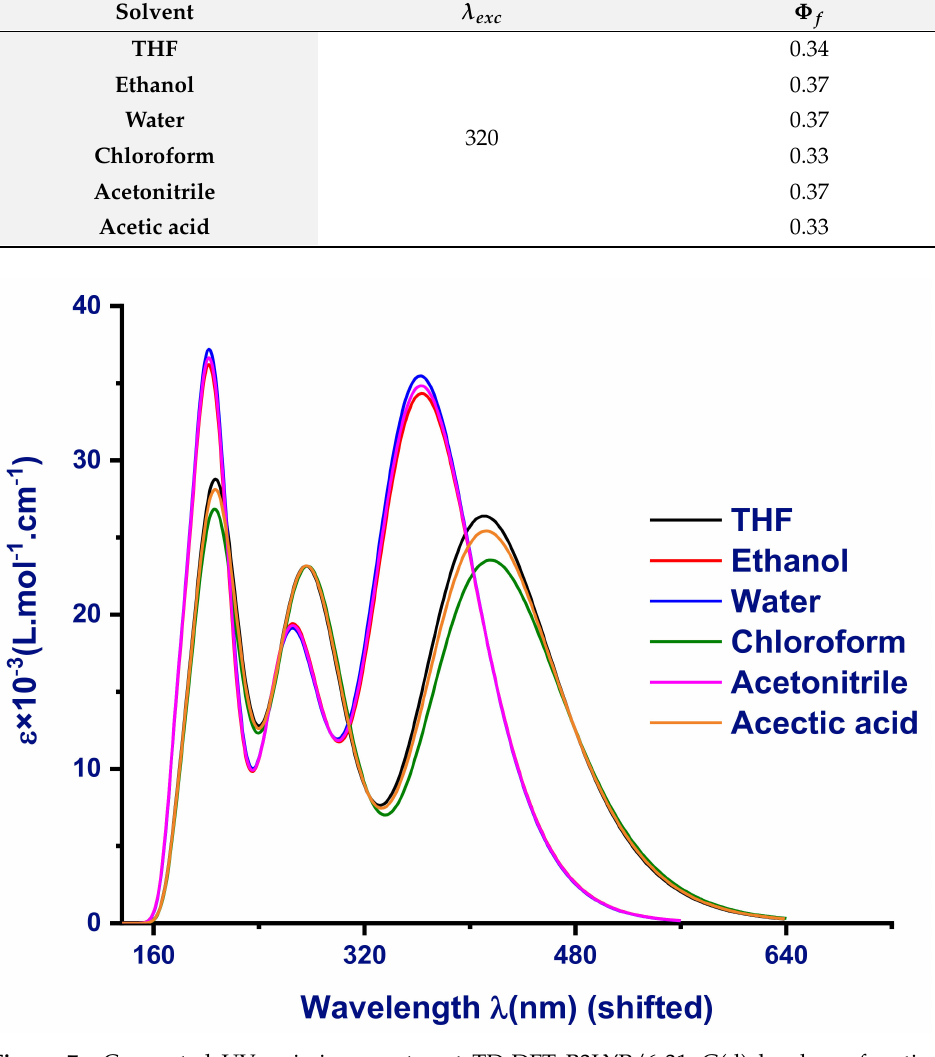
Figure 7. Computed UV-emission spectra at TD-DFT B3LYP/6-31+G(d) level as afunction of several